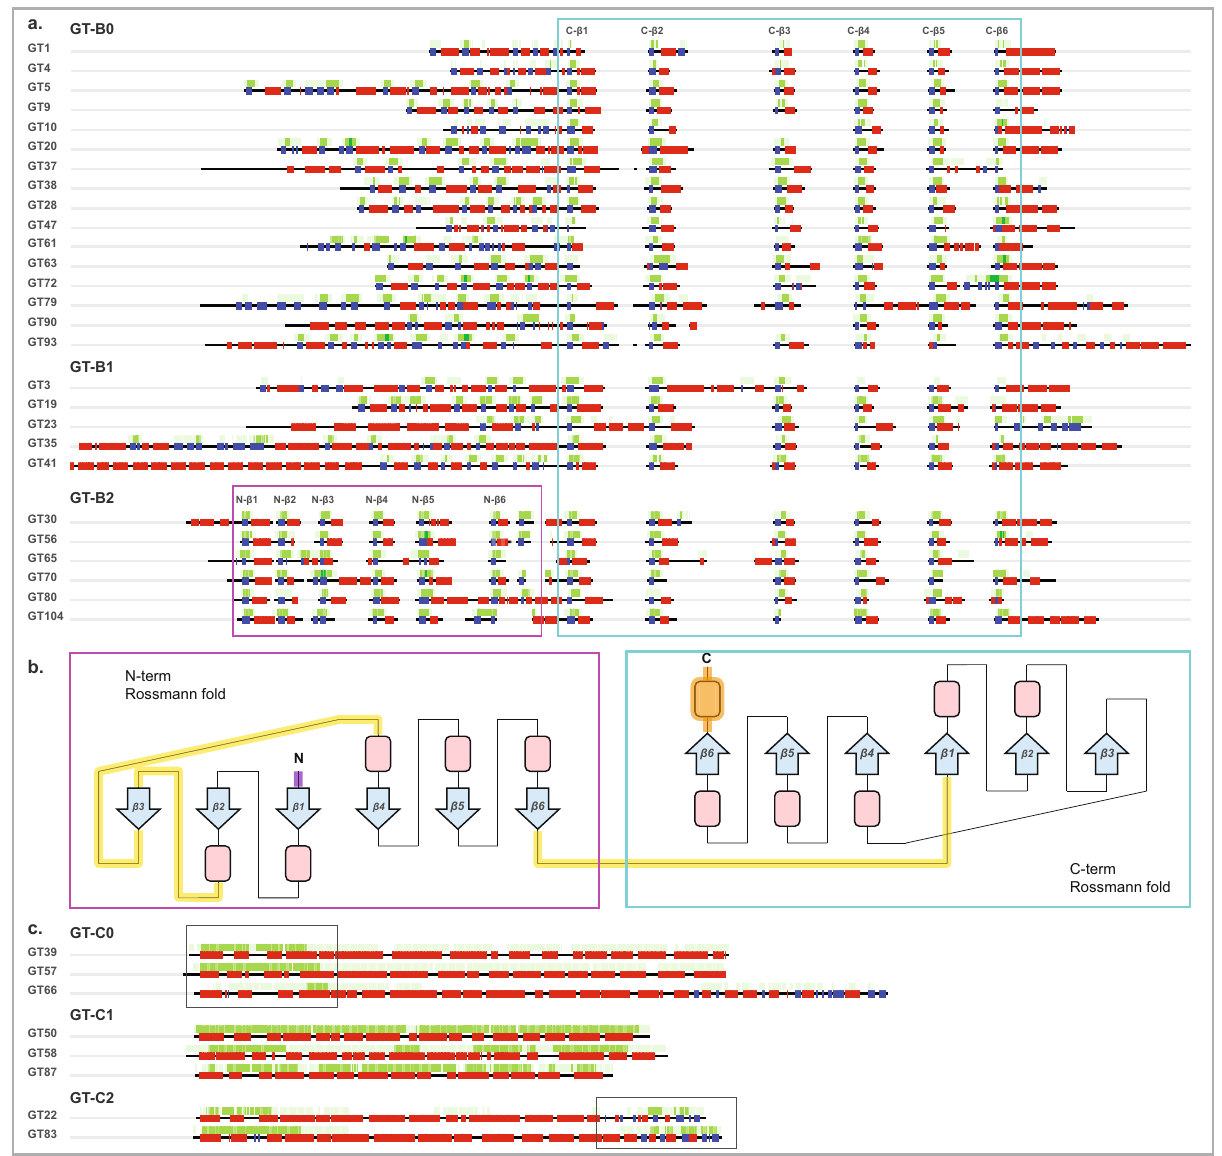
Fig. 4 CAM maps for the different GT-B and GT-C fold clusters highlight their respective conserved cores. a Consensus secondary structure (blue: beta-sheets; red: helices; green: loops) and average CAM values (higher intensity of green corresponds to a higher CAM value) from layer 2 are shown for all families belonging to the three GT-B fold clusters. These average values were generated from sequence alignments within each family. High CAM values within the cyan box point to the C-terminal Rossmann fold conserved across all GT-B fold members and the magenta box points to the N-terminal Rossmann fold conserved in GT-B2. b A topological representation of the conserved features of GT-B. The conserved C-terminal Rossmann-like fold region is shown in the cyan box. The N-terminal Rossmann fold, which is most conserved in members of GT-B2 cluster is shown in the magenta box. Conserved beta-sheets are shown as blue arrows with labels, and alpha-helices are shown as red boxes. Loop regions that have the most variability across families are indicated by yellow lines. Purple N-terminal loop and orange C-terminal helix indicate the presence of variable secondary structures preceding the N-terminal and following the C-terminal Rossmann fold, respectively. c Consensus secondary structure and average CAM values from layer 3 for GT-C families from clusters GT-C0, GT-C1, and GT-C2. Boxes indicate regions with higher average layer 3 CAM values for GT-C0 and GT-C2 in the N-terminal and the C-terminal regions, respectively. For GT-C1, layer 3 CAM is high throughout the full length of the sequences. Source data are provided as a Source Data fi